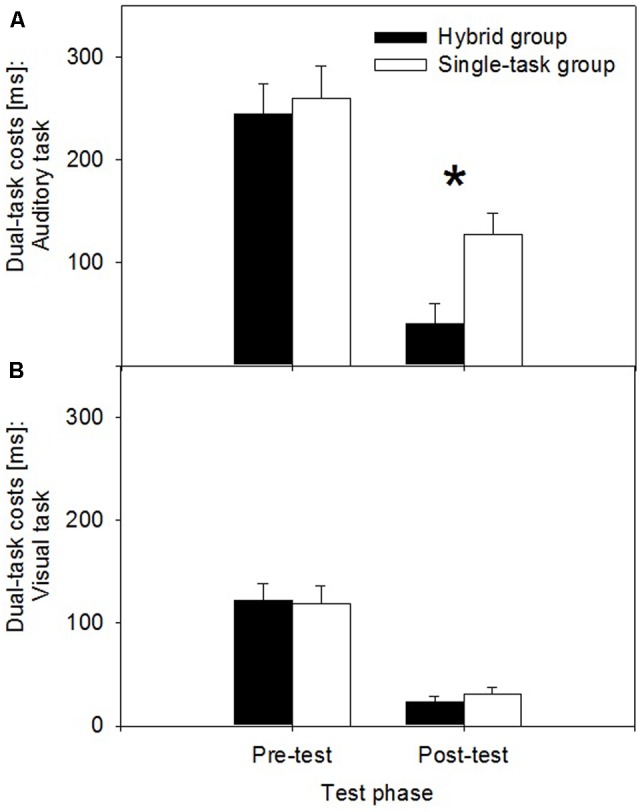
Dual-task costs in millisecond (ms; dual-task RTs minus single-task RTs) during pre-test and post-test for the single-task practice group (Single-task group) and the hybrid practice group (Hybrid group). (A) Auditory-task data; (B) Visual-task data. The asterisk denotes the significant difference.